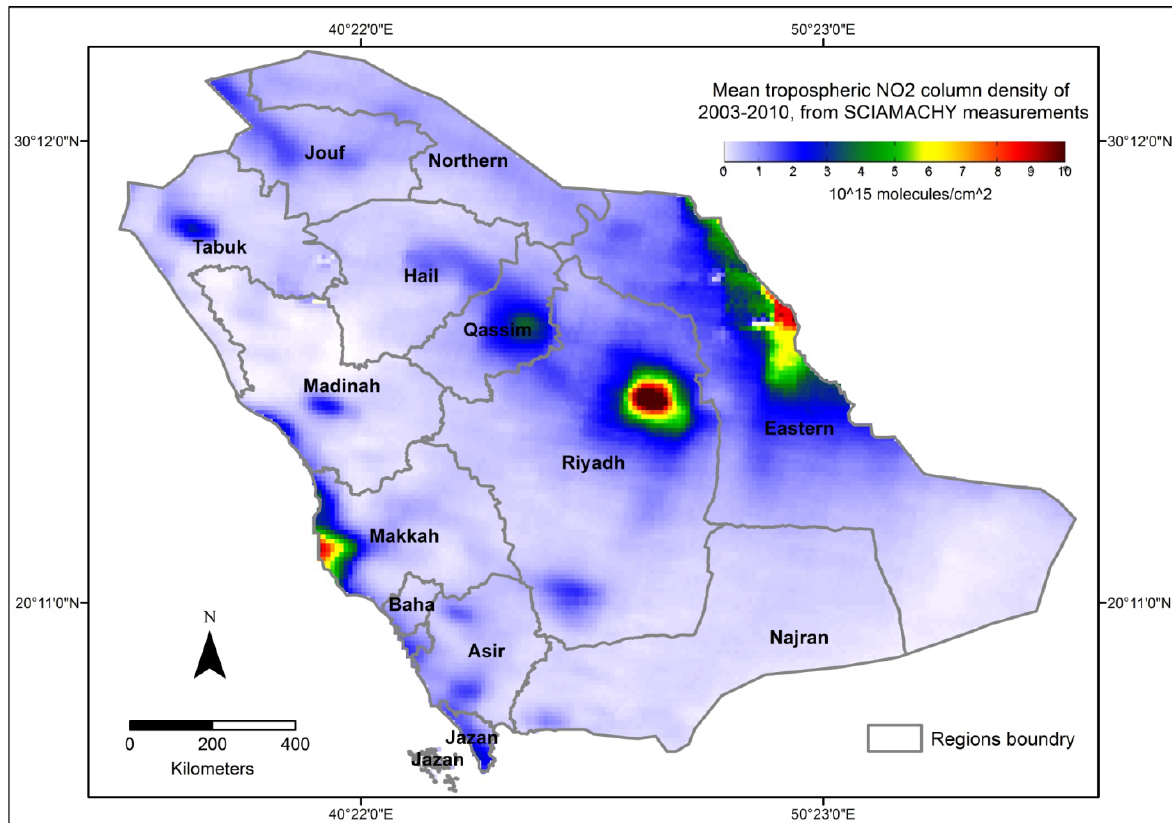
column density, 2